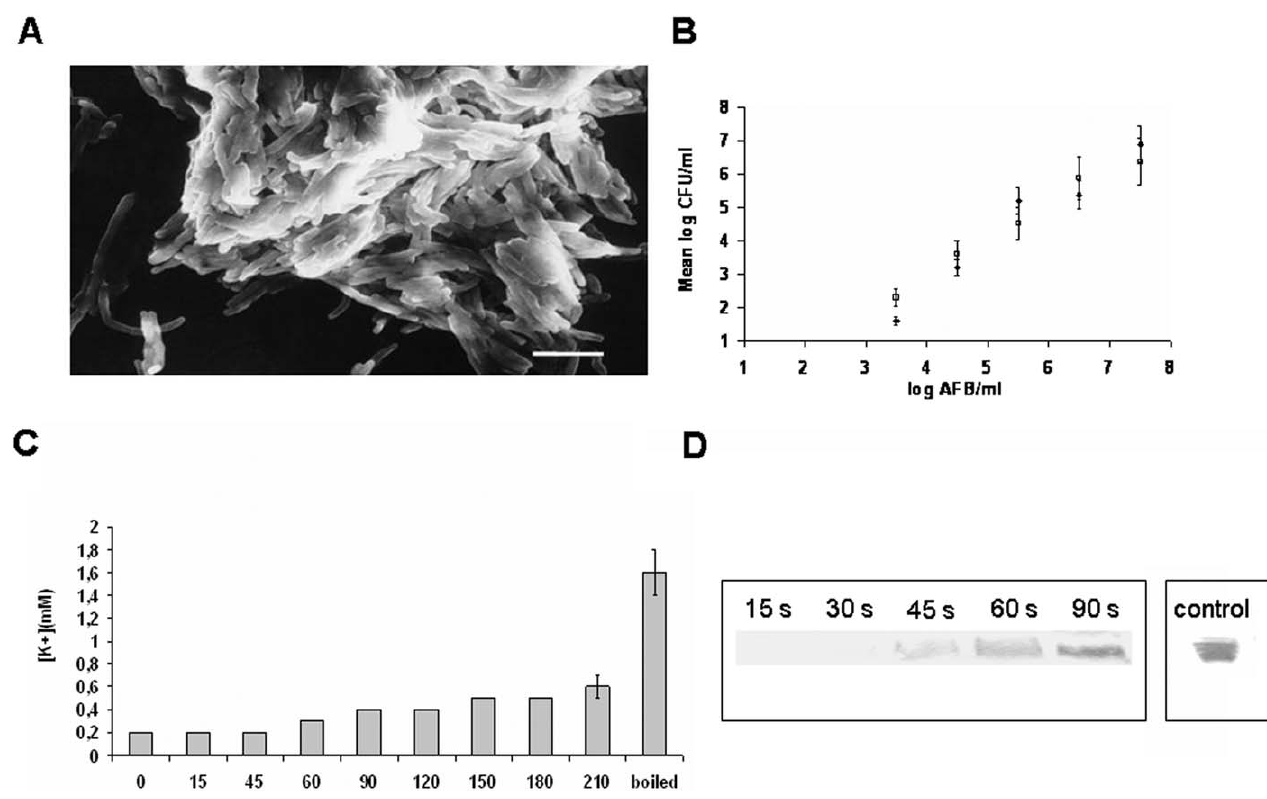
Figure 3. Impact of ECM Removal on M. ulcerans Cultivability and Permeability (A) Scanning electron micrographs of M. ulcerans recovered after ECM extraction. The ECM could be removed by vortexing the cells with glass beads in Tween 80 0.05%. Scale bars: 5 l m. (B) The effect of removal of ECM on the growth of M. ulcerans . CFUs onto Lo¨wenstein–Jensen slants were determined after inoculation of serial dilutions of bacterial suspension (Acid Fast Bacilli [AFB]). Open symbols: CFUs from sample without ECM; filled symbols: bacterial clusters with ECM. Mean value 6 standard error of the mean (S.E.M.) of three samples. (C) Potassium release assay in bacterial supernatant of M. ulcerans culture sample taken at different times after mechanical treatment with detergent for ECM removal. Each time point is the mean value 6 S.E.M. of three independent assays. Boiled corresponds to the supernatant of boiled bacteria. Significant difference was obtained after 60 s of treatment. (D) Detection of KatG by Western blotting on M. ulcerans culture sample after mechanical treatment with detergent for ECM removal. Bacterial supernatant (30 l l) was taken at different times after treatment by beads and detergent was loaded on a 4%–12% SDS-PAGE gel and transferred to nitrocellulose. Detection was performed with rabbit polyclonal serum anti-KatG serum and anti-rabbit horseradish peroxidise-conjugated IgG. KatG was detected after only 45 s of treatment. Proteins (60 l g) extracted from M. ulcerans lysate were used for positive